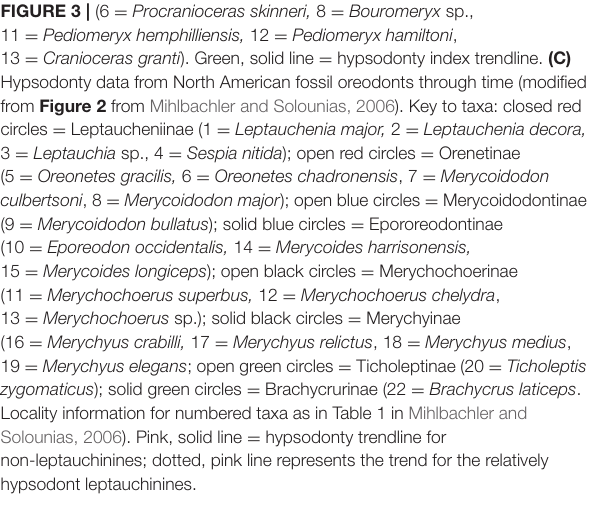
FIGURE 3 | (6 = Procranioceras skinneri, 8 = Bouromeryx sp., 11 = Pediomeryx hemphilliensis, 12 = Pediomeryx hamiltoni , 13 = Cranioceras granti ). Green, solid line = hypsodonty index trendline. (C) Hypsodonty data from North American fossil oreodonts through time (modified from Figure 2 from Mihlbachler and Solounias, 2006). Key to taxa: closed red circles = Leptaucheniinae (1 = Leptauchenia major, 2 = Leptauchenia decora, 3 = Leptauchia sp., 4 = Sespia nitida ); open red circles = Orenetinae (5 = Oreonetes gracilis, 6 = Oreonetes chadronensis , 7 = Merycoidodon culbertsoni , 8 = Merycoidodon major ); open blue circles = Merycoidodontinae (9 = Merycoidodon bullatus ); solid blue circles = Epororeodontinae (10 = Eporeodon occidentalis, 14 = Merycoides harrisonensis, 15 = Merycoides longiceps ); open black circles = Merychochoerinae (11 = Merychochoerus superbus, 12 = Merychochoerus chelydra , 13 = Merychochoerus sp.); solid black circles = Merychyinae (16 = Merychyus crabilli, 17 = Merychyus relictus , 18 = Merychyus medius , 19 = Merychyus elegans ; open green circles = Ticholeptinae (20 = Ticholeptis zygomaticus ); solid green circles = Brachycrurinae (22 = Brachycrus laticeps . Locality information for numbered taxa as in Table 1 in Mihlbachler and Solounias, 2006). Pink, solid line = hypsodonty trendline for non-leptauchinines; dotted, pink line represents the trend for the relatively hypsodont